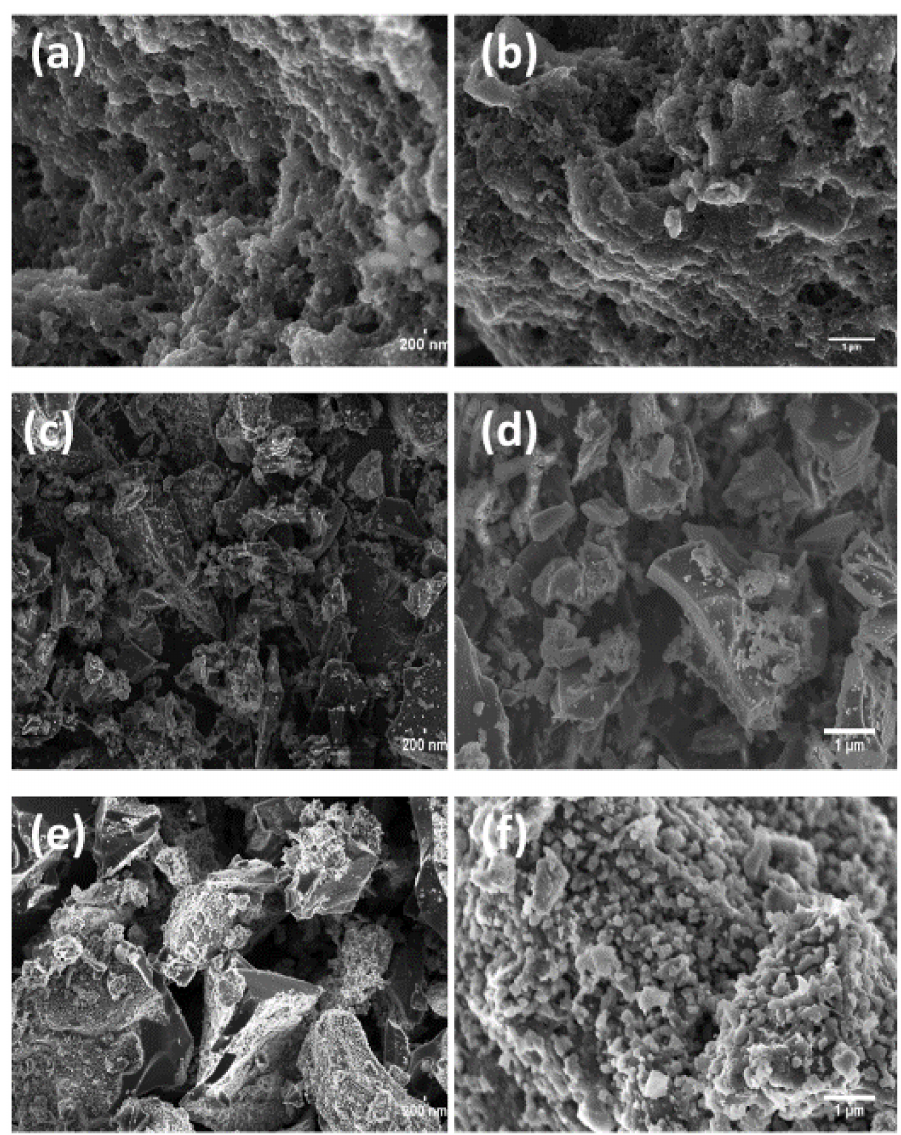
Figure 3. Field Emission Scanning Electron Microscopy (FESEM) micrographs for AC-S samples taken at two di ff erent magnifications AC-S-600 at ( a ) 200 nm, ( b ) 1 µ m, AC-S-700 at ( c ) 200 nm, ( d ) 1 µ m, AC-S-800 at ( e ) 200 nm, ( f ) 1 µ